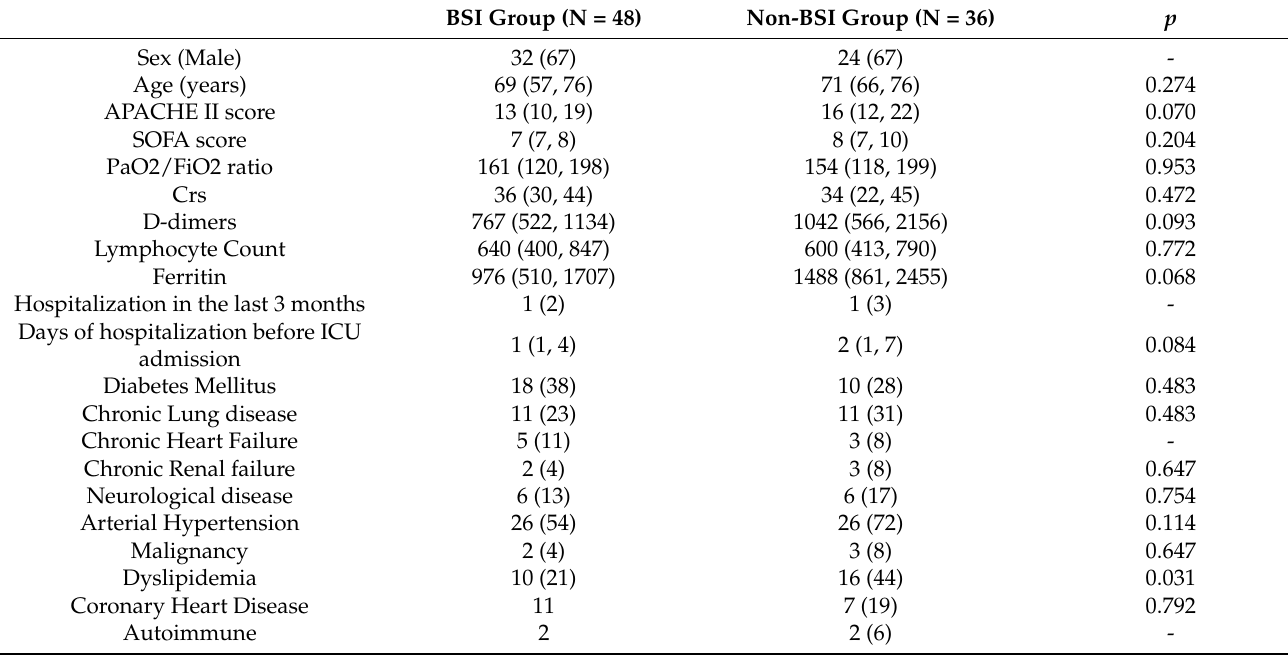
Table 1. Baseline characteristics during ICU